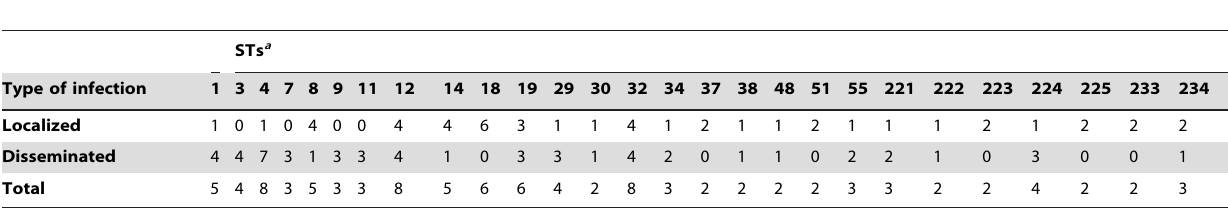
Table 3. Distribution of B. burgdorferi STs between Lyme disease patients with disseminated and localized infection.